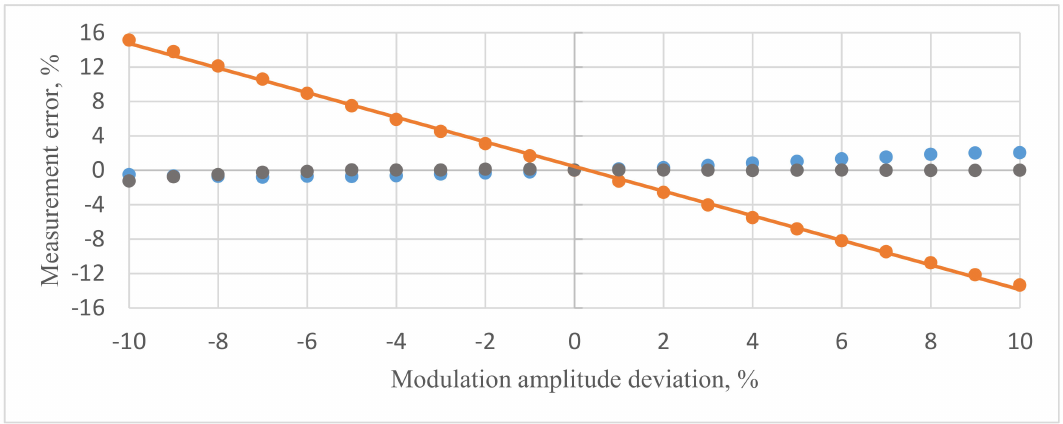
Figure 7. Measurement error vs modulation amplitude deviation of the optimal value in the range of ± 10%. Blue—compensation with coe ffi cients during numerical simulation, orange—without compensation, black—compensation with experimentally selected coe ffi